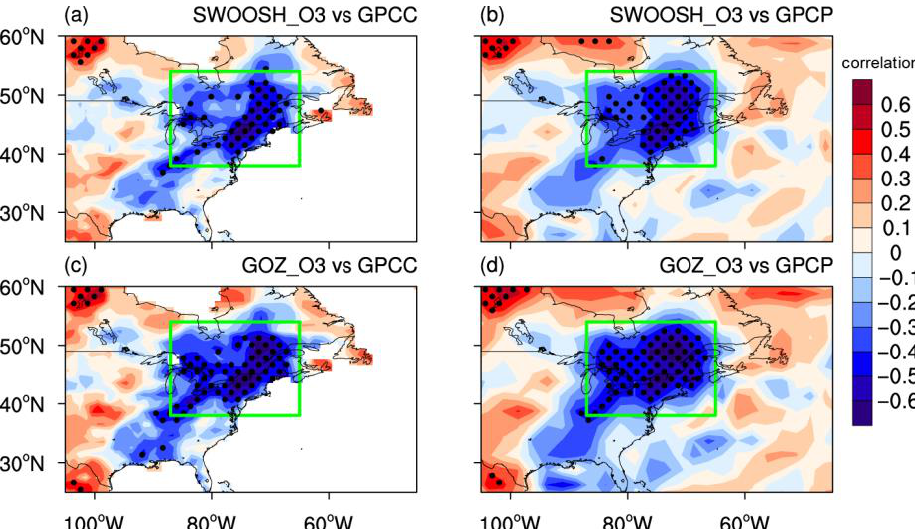
Figure 1. Correlation coefficient maps between the March ASO index and April precipitation anomalies for ( a , b ) 1985 – 2019 and ( c , d ) 1985 – 2012. ASO indices are calculated based on the ( a , b ) SWOOSH and ( c , d ) GOZCARDS datasets; precipitation data are derived from ( a , c ) GPCC and ( b , d ) GPCP. In ( a – d ), the long-term linear trends of the ASO index and precipitation were removed prior to the correlation analysis. Stippling denotes areas where correlation coefficients are significant at the 95% confidence level. The green square indicates the study area.